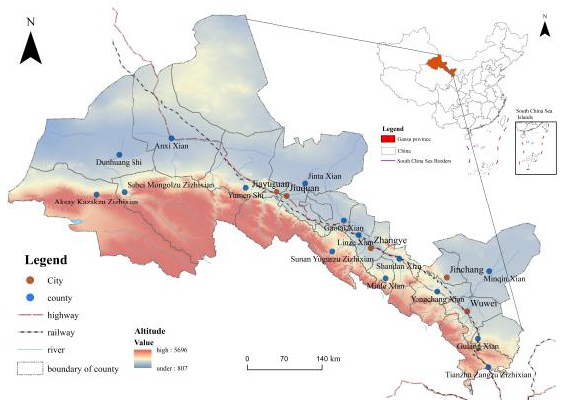
Figure 1. Research scope.